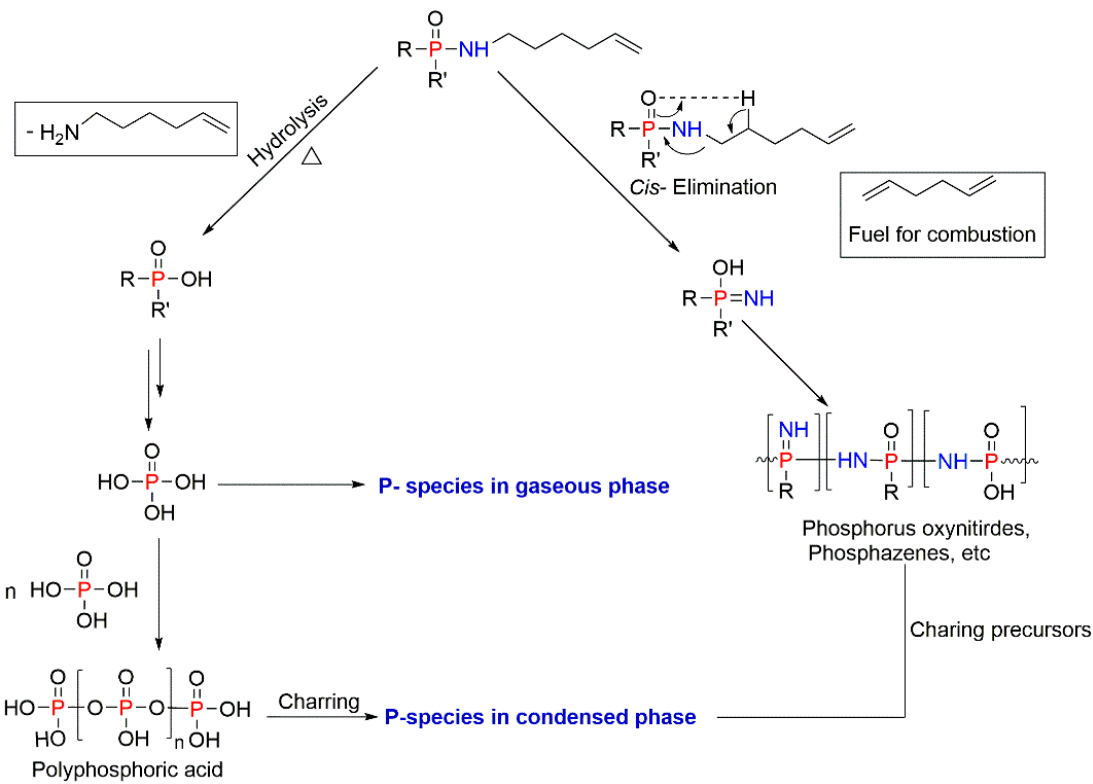
Figure 23. Decomposition mechanisms of the reactive P–N-containing FRs [116].